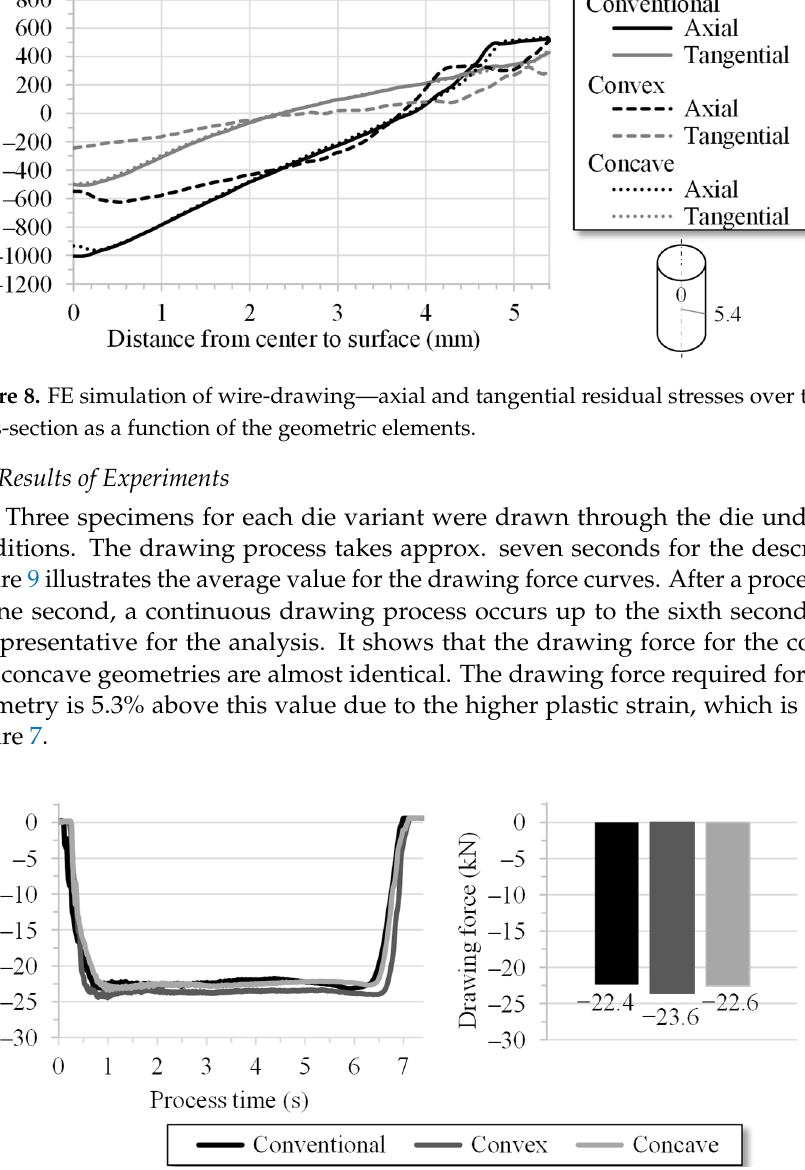
Figure 9. Experimental drawing forces of the die geometry variants, conventional, convex and concave (three specimens per variant).